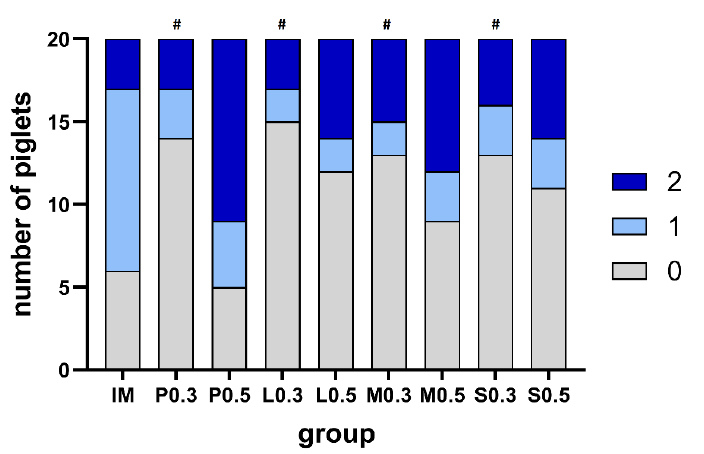
Figure 4. Nocifensive movements to intratesticular injection for the groups IM, P 0.3 , P 0.5 , L 0.3 , L 0.5 , M 0.3 , M 0.5 , S 0.3 and S 0.5 . Number of piglets with a score of 0 are displayed in grey, a score of 1 in light blue and a score of 2 in dark blue. The # represents a significant difference compared to group IM.